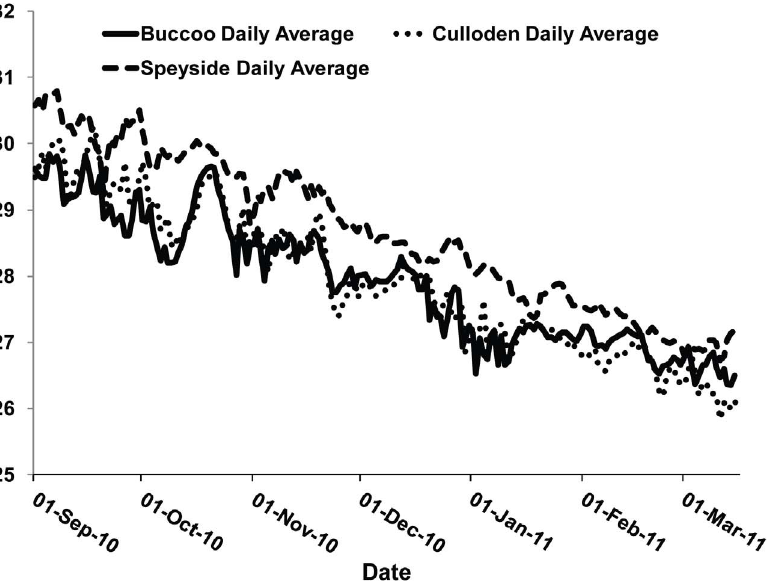
Figure 3. Average daily insitu (10 m) temperatures at Buccoo, Culloden and Speyside reefs during the 2010 mass bleaching event (September 2010 to March 2011).